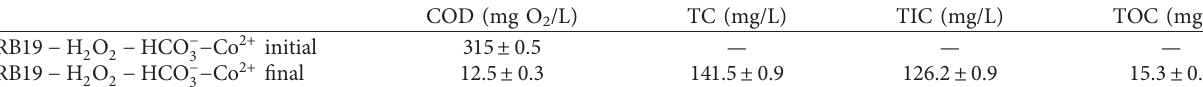
Table 4: Determination of COD and TOC of RB19 degradation.